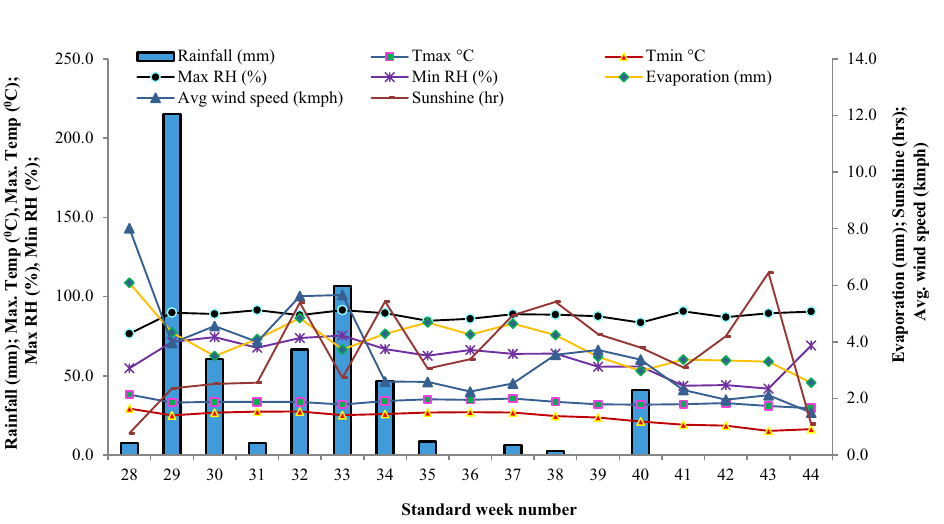
Figure 11. Weekly weather conditions during the cropping period of Kharif season maize in the Indo-Gangetic Plains,